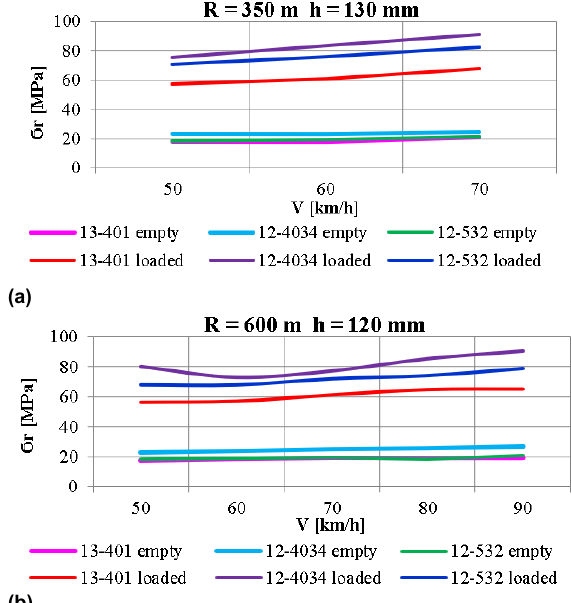
Figure 17. Variation of the edge stress in the rail base with the motion speed: (a) R=350 m curve; (b) R=600 m curve